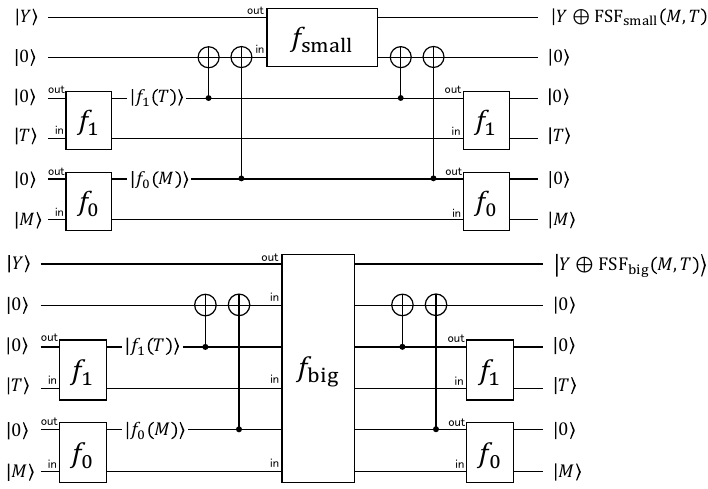
Figure 5: Implementation of FSF small and FSF big . “ in ” and “ out ” denote the registers to send queries and receive answers, respectively. The functions f 0 , f 1 , f small , and f big will be implemented with the recording standard oracle with errors in security